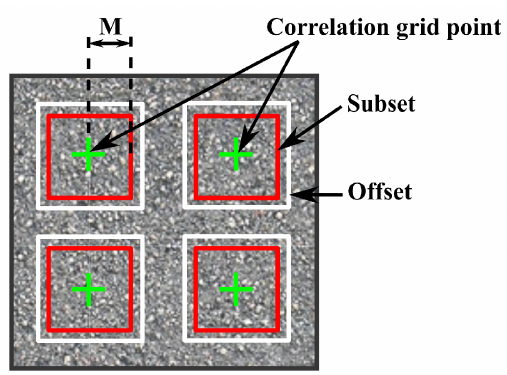
Figure 2. Parameters of the Digital Image Correla- tion points , parameter M represents the dimension of subset